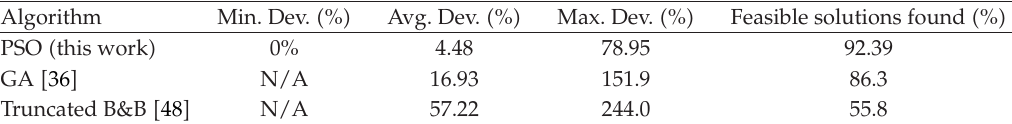
Table 16: Comparison of algorithms with respect to computation time—1 sec. on